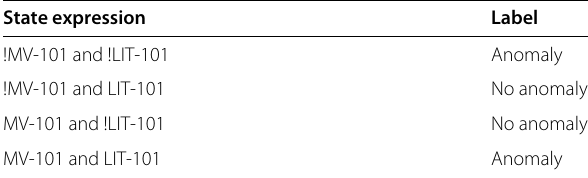
Table 6 State expressions of Invariant #1 for SWaT State expression